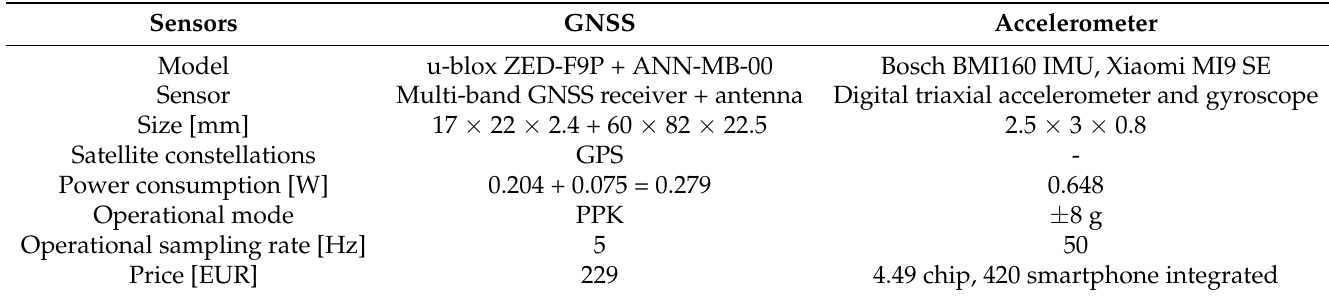
Table 1. Instrumental characteristics and modes of primary sensors in CB, Artificially Induced Displacement (AID) and steady MI experiment.